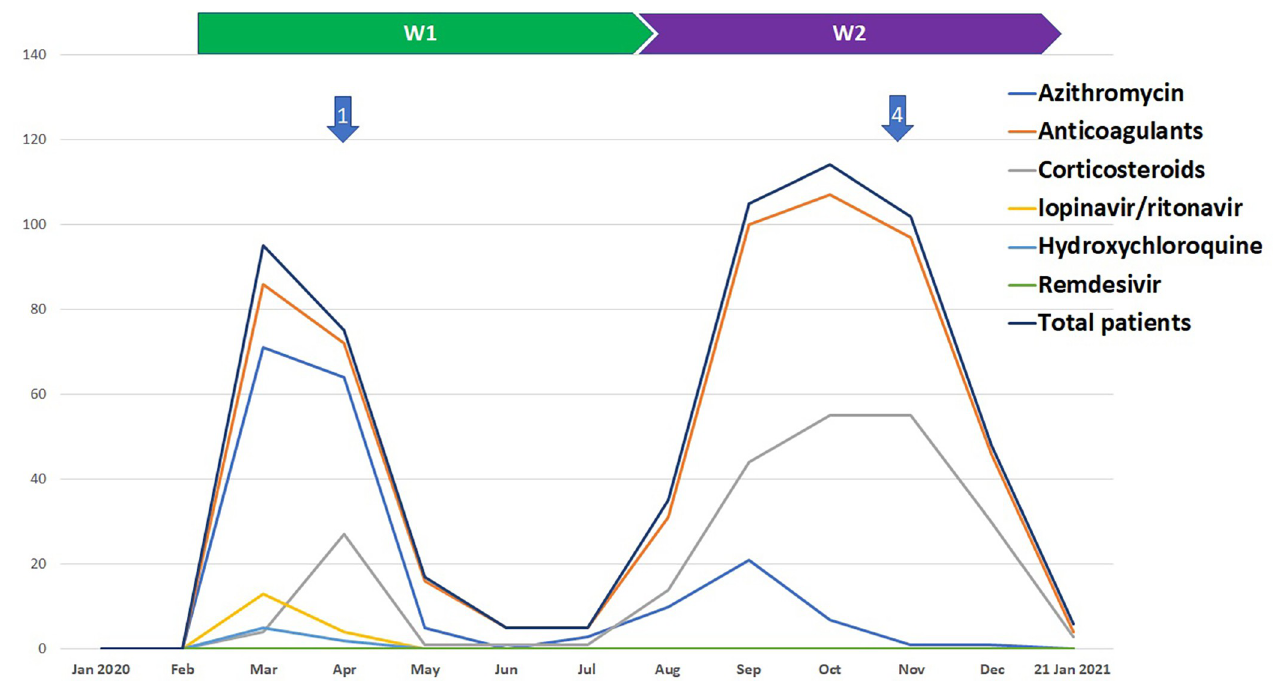
Fig 1. Monthly trends in prescriptions of specific anti-COVID-19 therapies (excluding clinical trials � ) in hospitalized patients, and main recommendations of the COVID RCP (numbered arrows) during the first two waves (W1 and W2). Arrow n˚1: HCSP and ISTH [7, 8] official recommendations, and critical analysis of the first publications concerning the lopinavir-ritonavir [9] combination, hydroxychloroquine (HCQ)-azithromycin (AZT) [10] combination and remdesivir [11] by the COVID multidisciplinary consultation meeting (RCP) of the hospital. Arrow n˚2: First randomized trial involving hydroxychloroquine [12] and alerts from pharmacovigilance centres (HCQ ± AZT, lopinavir-ritonavir). Arrow n˚3: first randomized trial of dexamethasone [13]. Arrow n˚4: randomized trial on azithromycin [14]. � Clinical trials: HYCOVID (NCT04325893, n = 1) [3] and FORCE (NCT04371367, n = 21) [4] evaluating hydroxychloroquine and avdoralimab,